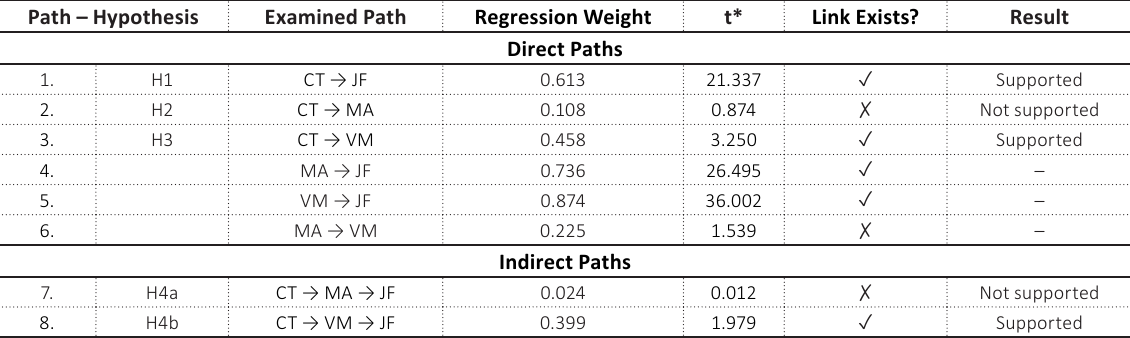
Table 3. PLS-SEM research model results Path – Hypothesis